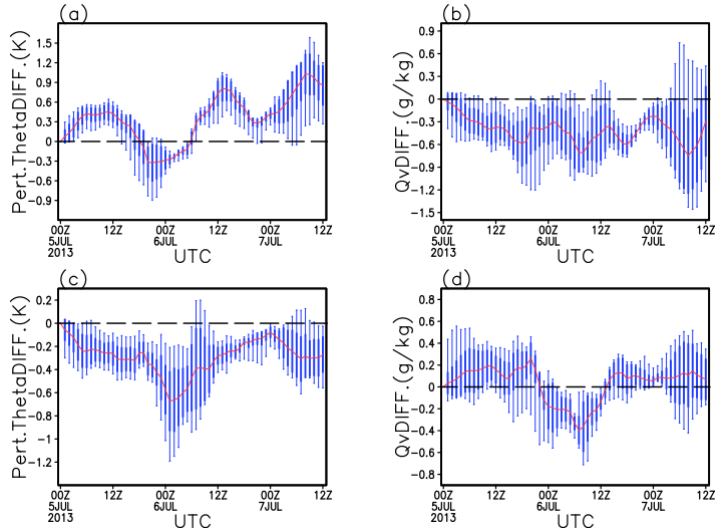
Figure 12. Time series of mean values (thick solid red line), standard deviations (blue boxes) and deviations (thin blue lines) of ( a ) 0~1.5 km perturbed potential temperature differences (units: K) and ( b ) 0~1.5 km water vapor mix ratio differences (units: g ⋅ kg −1 ) between the DP ensembles and the CTL experiment. ( c , d ) are the same as ( a , b ), but for the WP ensembles. The PBLH differences, 0~1.5 km vertical velocity differences and horizontal wind vector differences between sensitivity and the CTL experiments are further present to examine the PBL